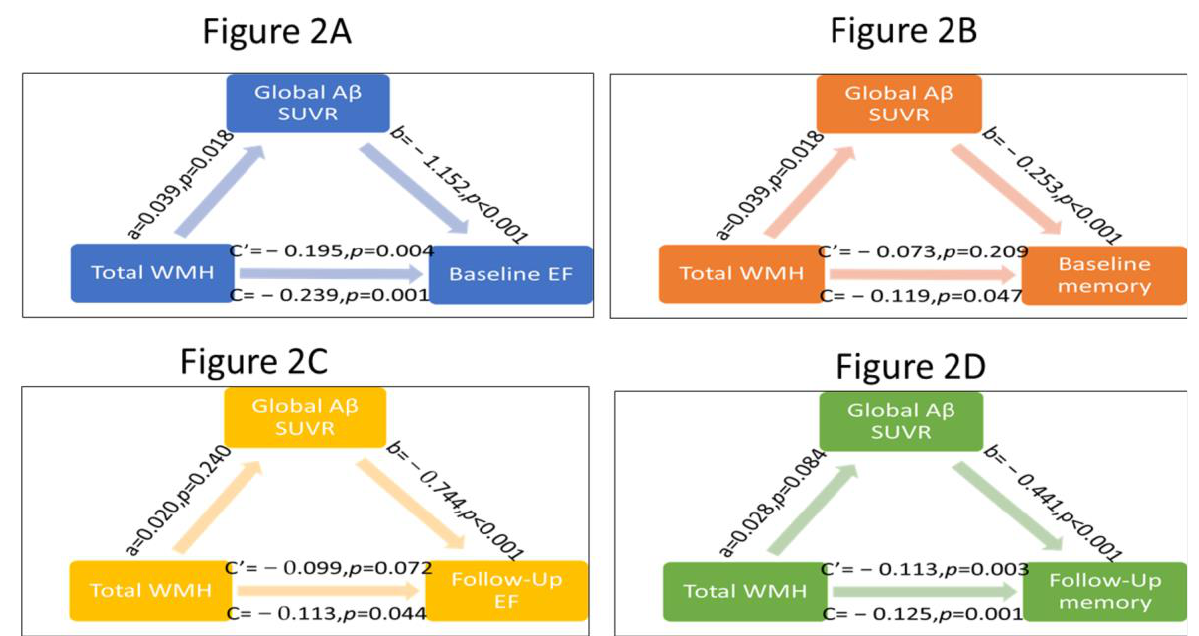
Figure 3: The correlation between regional and global Aβ burden, and WMH vol- Figure 2. Pat h models of the mediation effect of global and Aβ burden between WMH s and cogni- Figure 2. Path models of the mediation effect of global and A β burden between WMHs and umes. tive performance. cognitive performance.